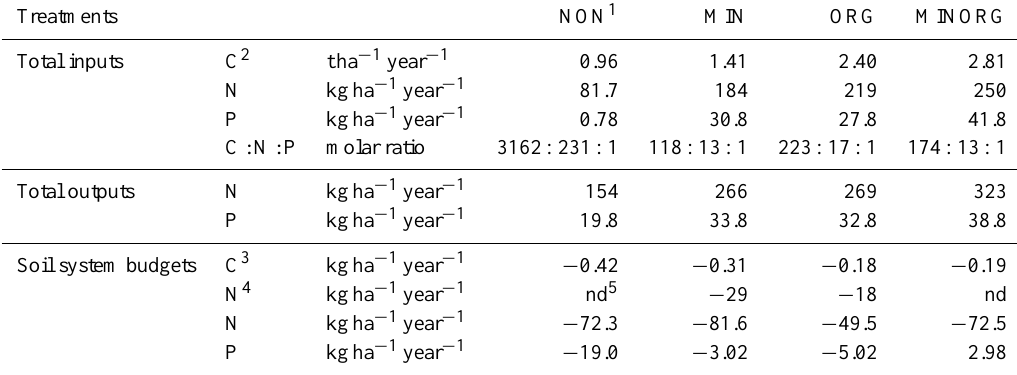
Table 6. Average C, N, and P in inputs and C:N:P molar ratios in inputs; N and P outputs; and C, N, and P soil system budgets for soil–plant systems subjected to different treatments in the DOK field experiment, Switzerland, for the period 1978–2006. Treatments NON 1 MIN Total inputs